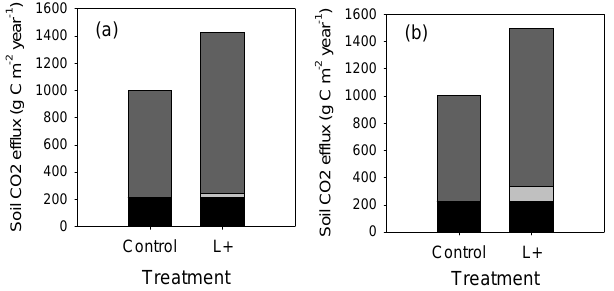
Figure 5. Simulated response of soil CO 2 efflux in control and lit- ter addition (L + ) experiments as described by Sayer et al. (2014) using model A (a) or B (b) . The dark-grey bar and black bars rep- resent CO 2 effluxes from litter and soil organic carbon decomposi- tion, respectively. The light-grey bar for the litter addition treatment represents the additional CO 2 efflux from soil organic carbon de- composition due to additional litter